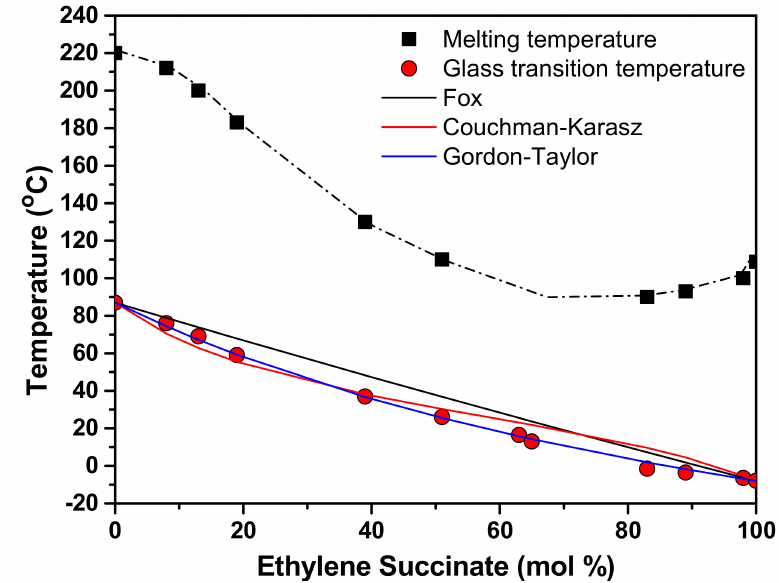
Figure 1. Alterations of the thermal characteristics of the materials depending on the comonomer ratio in PEF- co -PES copolymers